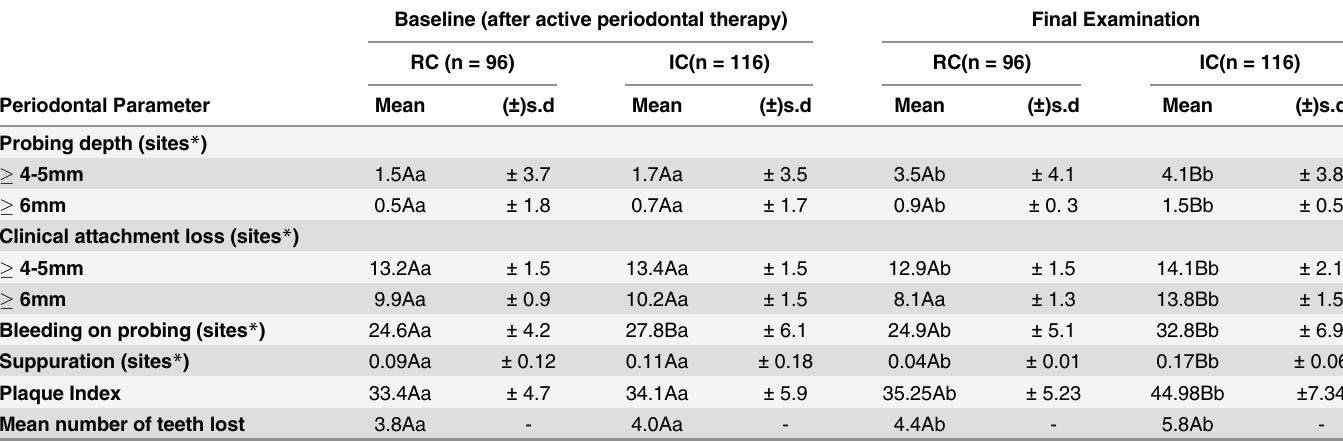
* Mean % of affected sites ± standard deviation Comparisons between groups within each examination time (baseline RC versus baseline IC, and fi nal RC versus fi nal IC) followed by distinct capital letters are signi fi cant different (Student-t test for independent samples). Comparisons between examination times within each group (baseline RC versus fi nal RC, and baseline IC versus fi nal IC) followed by distinct lower case letters are signi fi cant different (Student-t test for independent samples). Multiple comparisons adjusted by Bonferroni correction (p (cid:3)